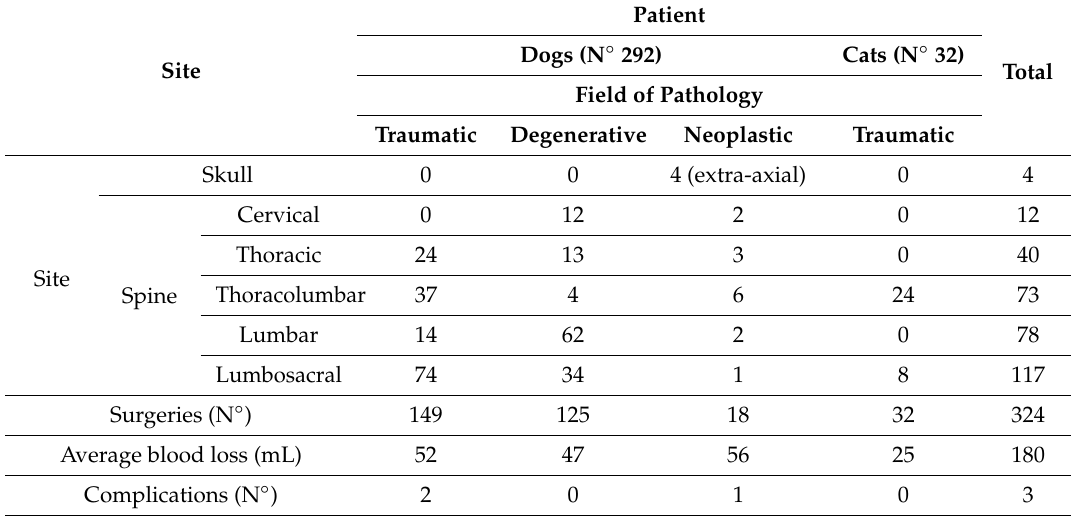
Table 1. Data about neurosurgical procedures performed with the piezoelectric bone